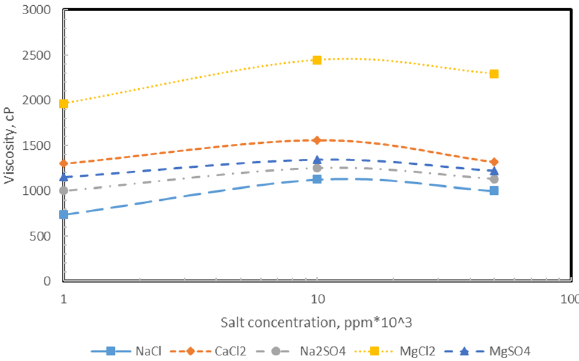
Figure 8. Effect of salt type and concentration on the viscosity of